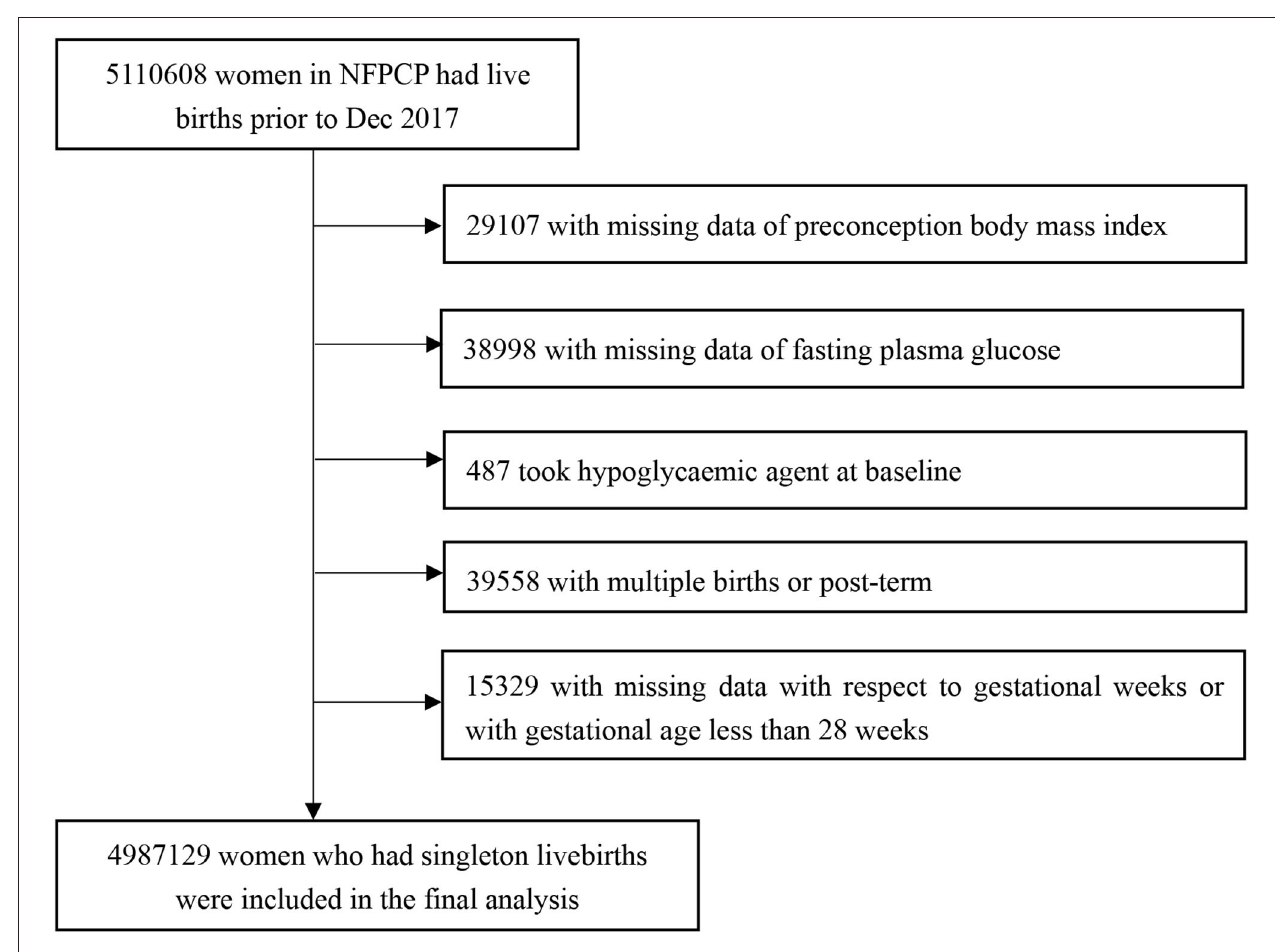
FIGURE 1 | Flowchart of the study participants. NFPCP, National Free Pre-Pregnancy Checkups